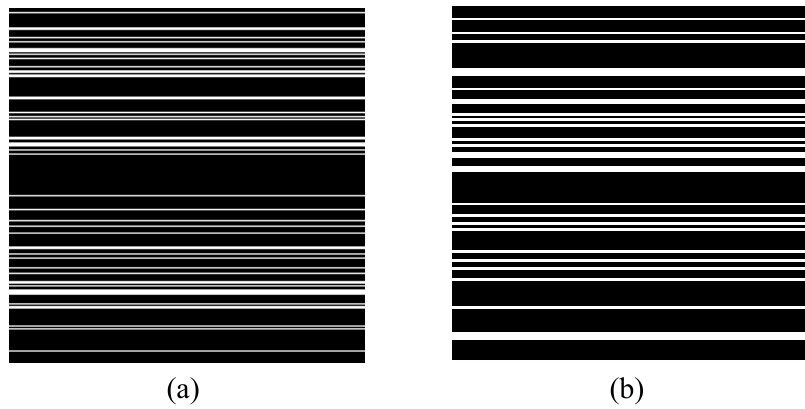
Figure 8. Sampling pattern used in simulation. ( a ) Cartesian sampling pattern with sampling rate 0.20 for the 2D 1 H- 1 H COSY spectrum ( N ( b ) Cartesian sampling pattern with sampling rate 0.25 for the 2D 1 H- 13 C COSY spectrum = 128 points) in Figure 5(a). ( N 1